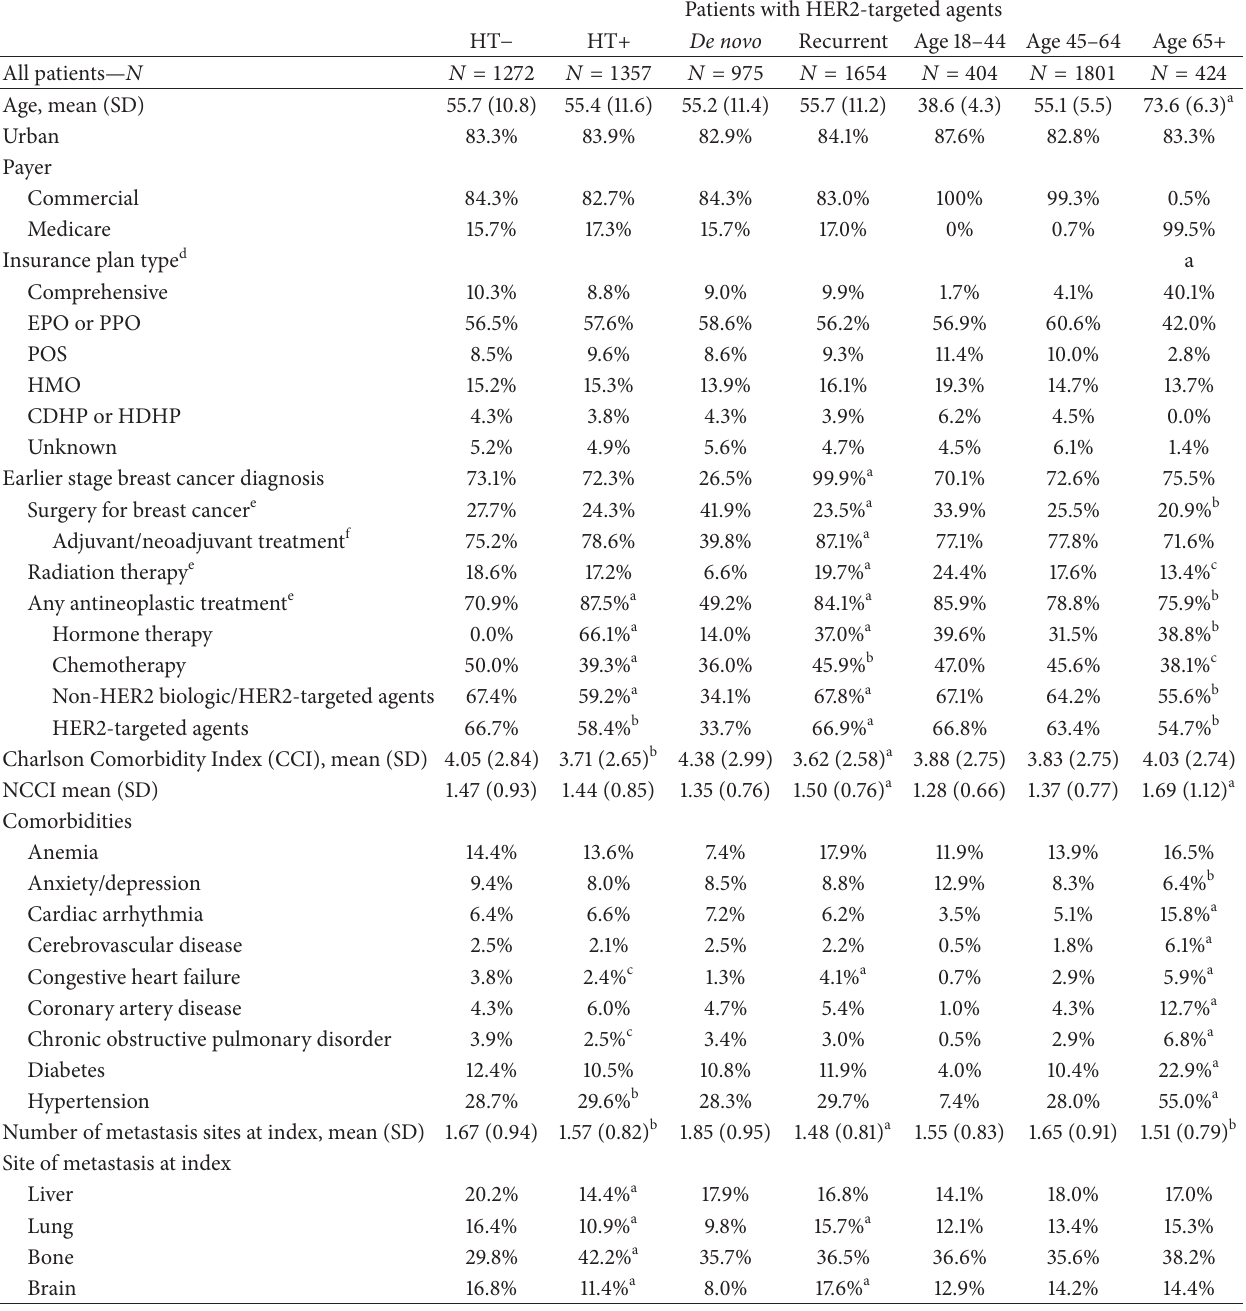
Table 2: Demographic characteristics and clinical history among patients with HER2-targeted